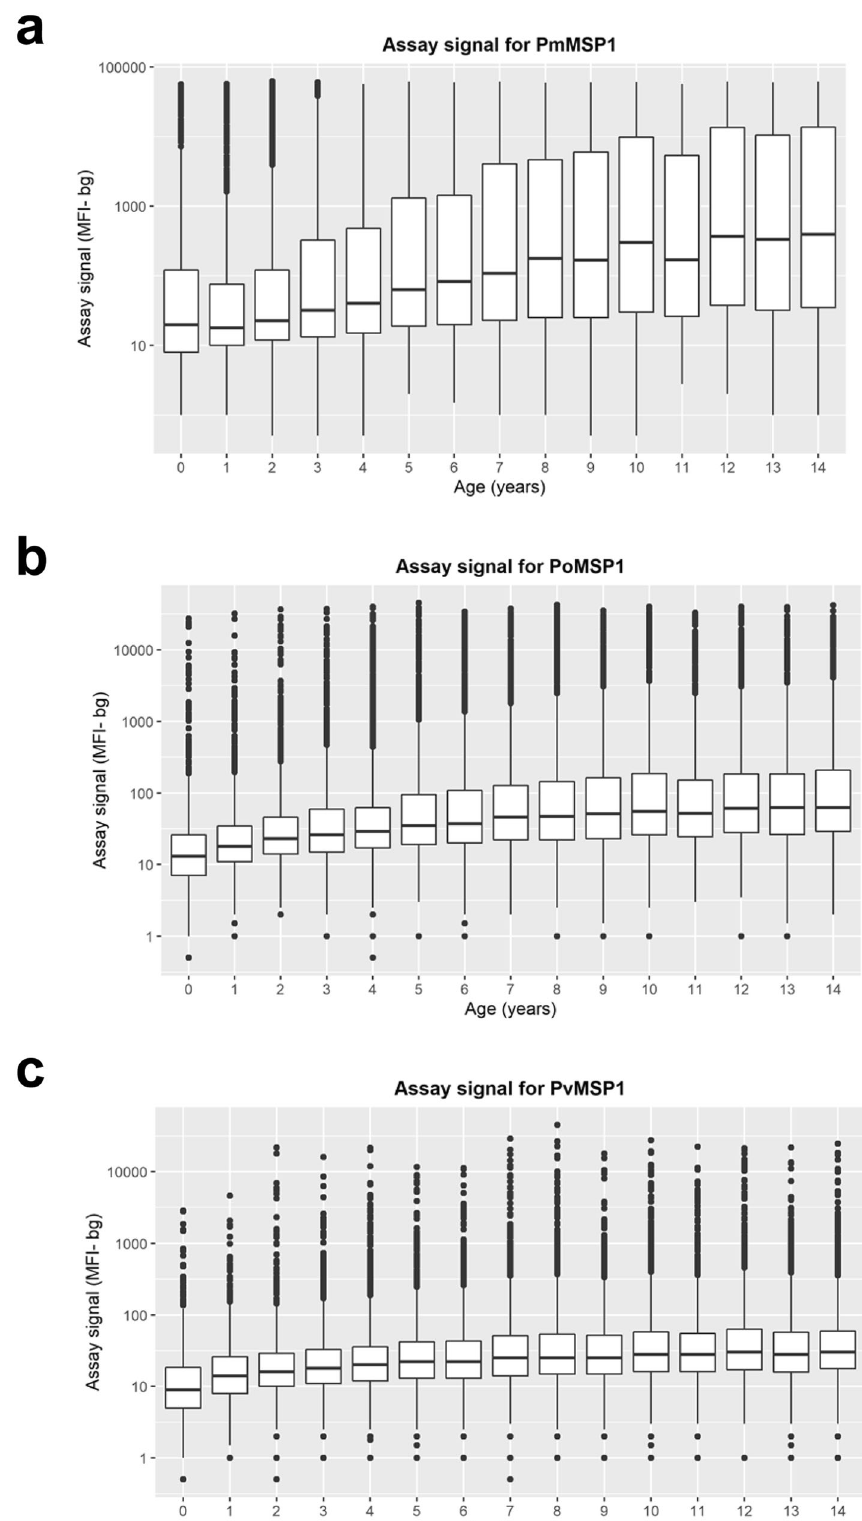
Fig. 4 | Changes in IgG antibody levels in Nigerian children during the fi rst 14 years of life. IgG antibody levels against PmMSP1 ( a ), PoMSP1 ( b ), and PvMSP1 ( c ) antigens by age. Boxes display interquartile range (IQR), with horizontal lines as